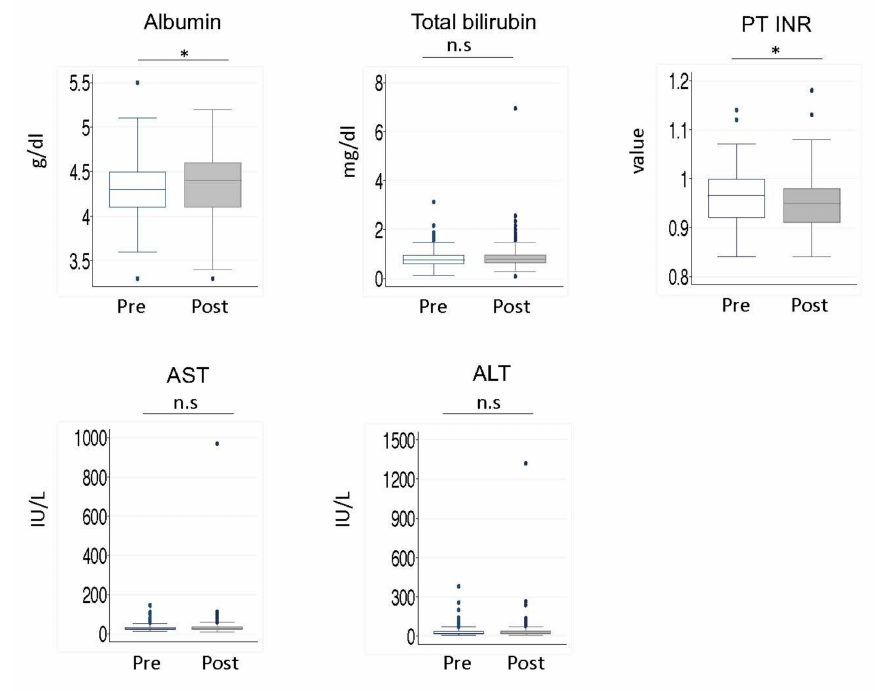
Figure 6. Changes in serum albumin (n = 218), total bilirubin (n = 216), prothrombin-time INR (n = 102), AST (n = 220), and ALT (n = 220) levels after vaccination in non-cirrhotic patients. *: p < 0.05, n.s.: not